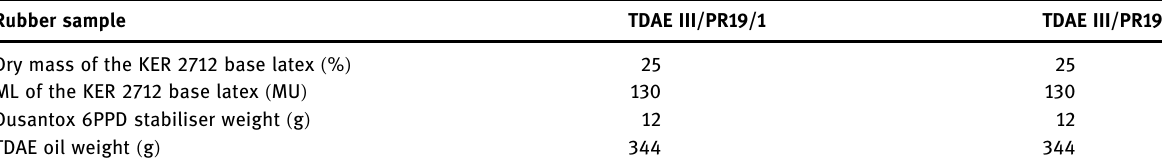
Table 7: Amount of substance and latex parameters during coagulation Rubber sample